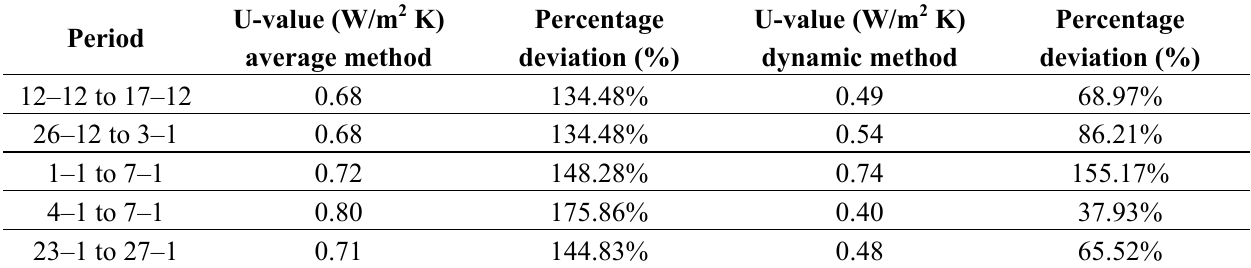
Table 6. U-value of the external wall using the HFM